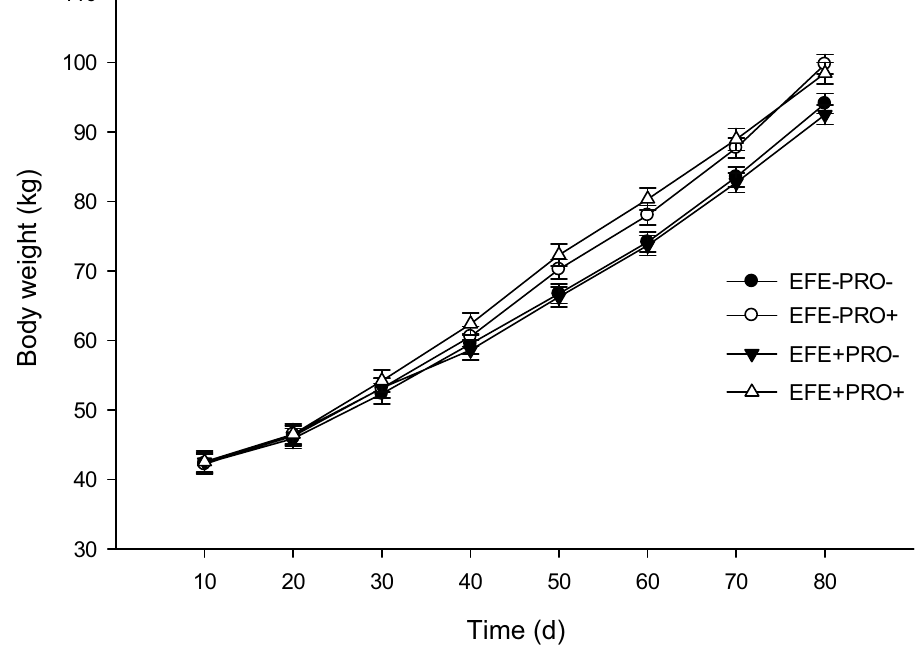
Figure 1. Body weight in calves receiving different experimental diets. Treatments were (1) calves fed diets without exogenous fibrolytic enzymes (EFE)-treated wheat straw and probiotic supplement (EFE-Pro−), (2) calves fed diets of EFE-treated wheat straw but with probiotic supplement (2 g/d/calf; EFE-Pro+), (3) calves fed EFE-treated wheat straw (2 g/d/calf) but without probiotic supplement (EFE+ Pro−), (4) calves fed EFE-treated wheat straw and probiotic supplement (EFE+ Pro+). Exogenous fibrolytic enzymes were applied to wheat straw. Data are presented as means ±